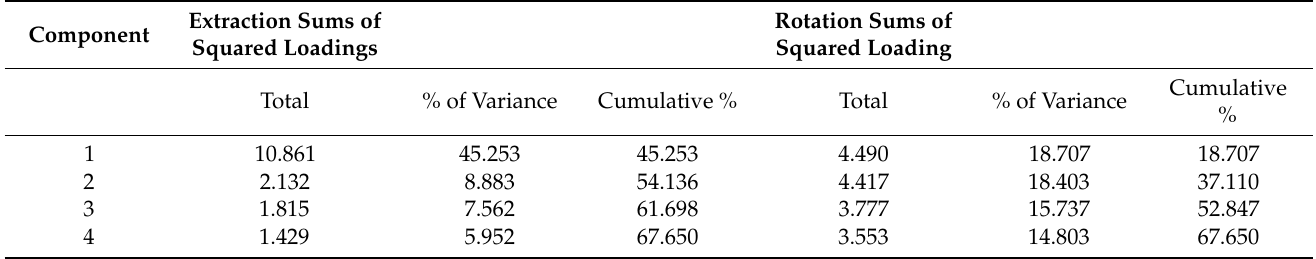
Table 4. Total Variance Explained.